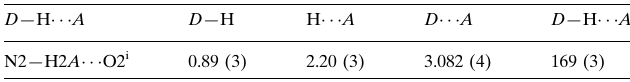
Hydrogen-bond geometry (A˚ , (cid:1)